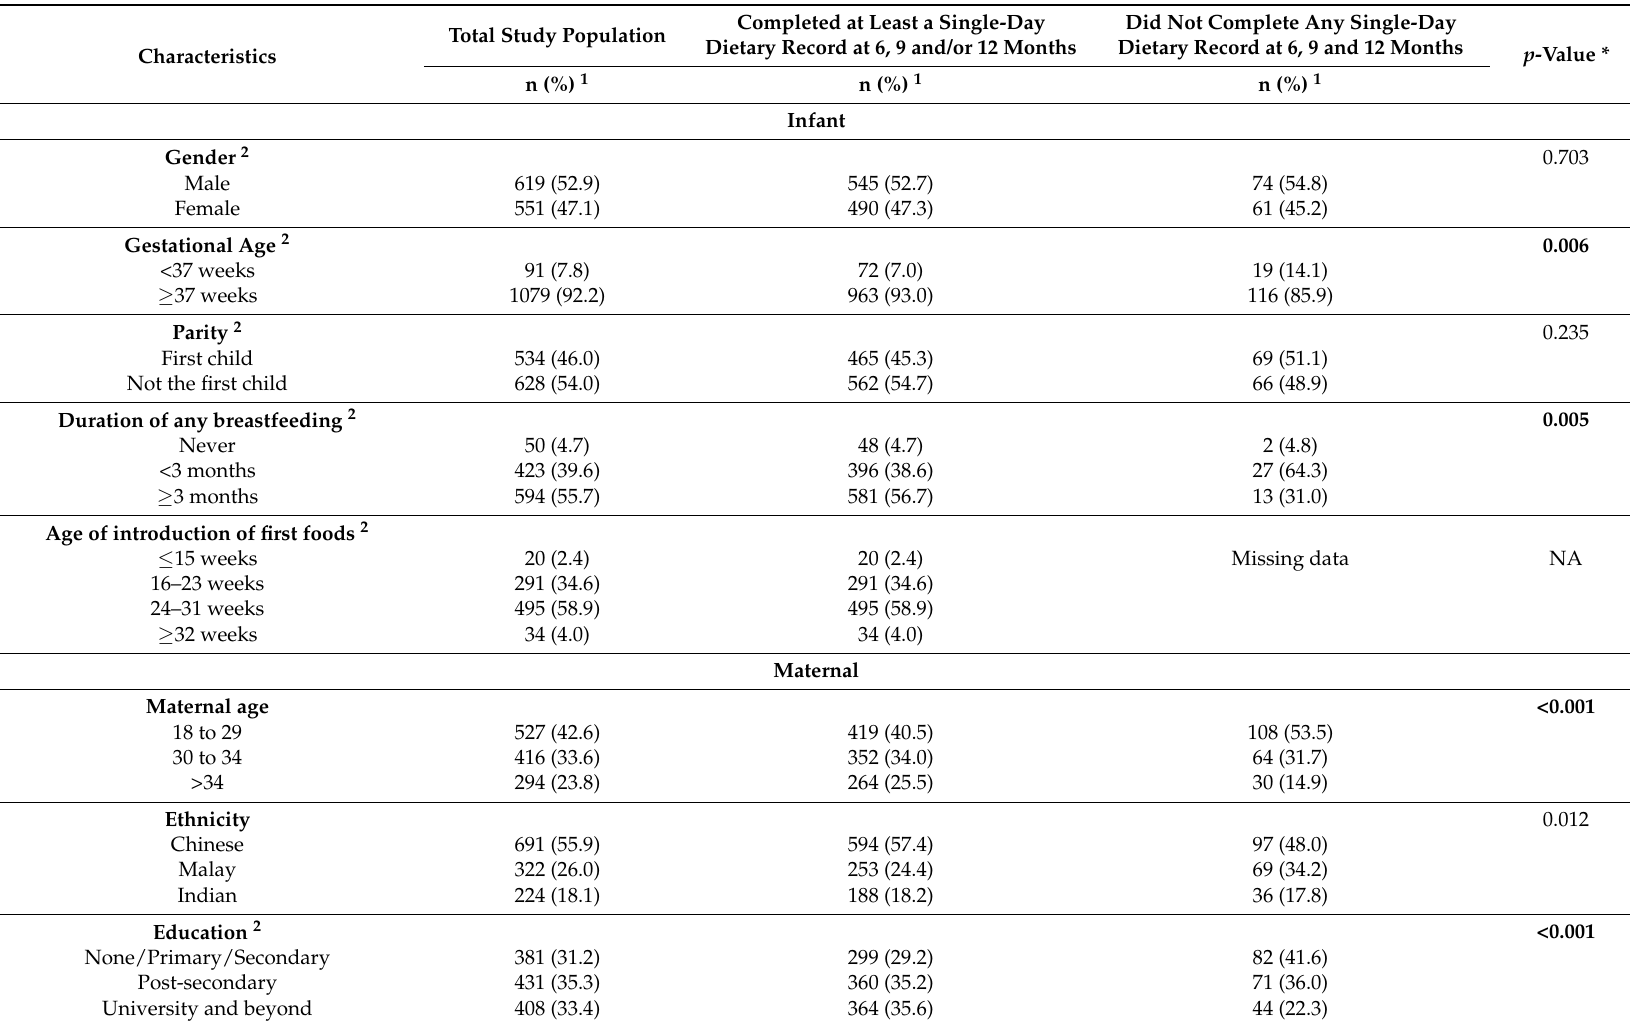
Table 1. Comparison of maternal and infant characteristics of single birth infants with at least 1 dietary record at 6, 9 or 12 months of age and those without any.